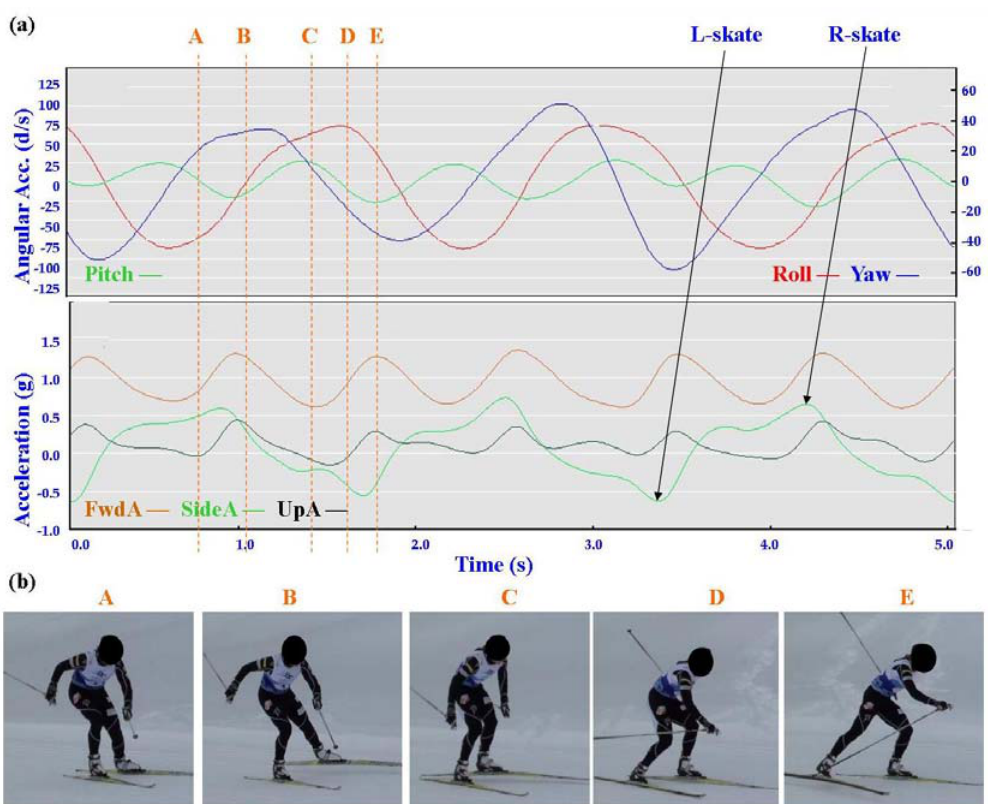
Figure 9. ( a ) Screenshot of Free Skate (G5) gyroscope and accelerometer traces against time; ( b ) G5 body position for selection